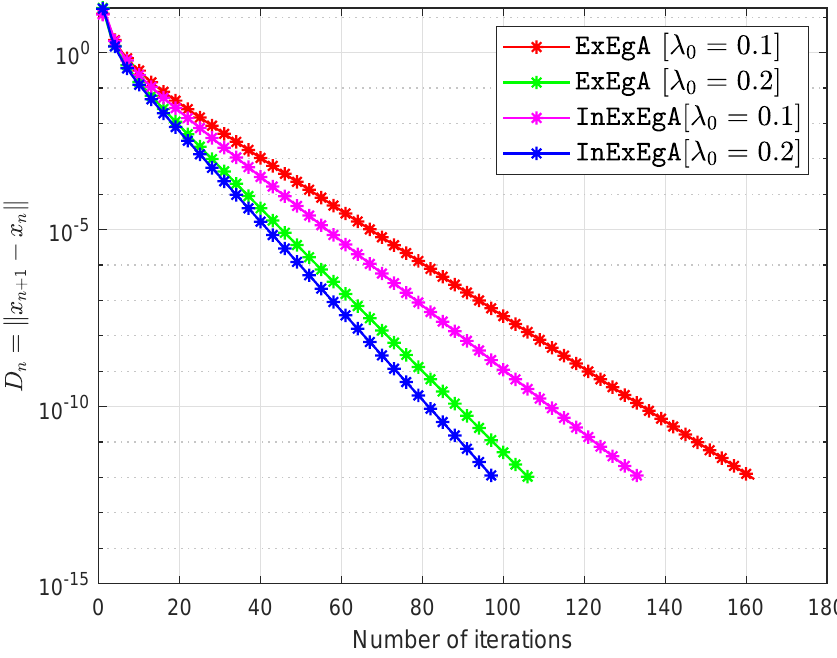
Figure 4. Algorithm 1 comparison with Algorithm 1 in [16] in term of iterations when n =